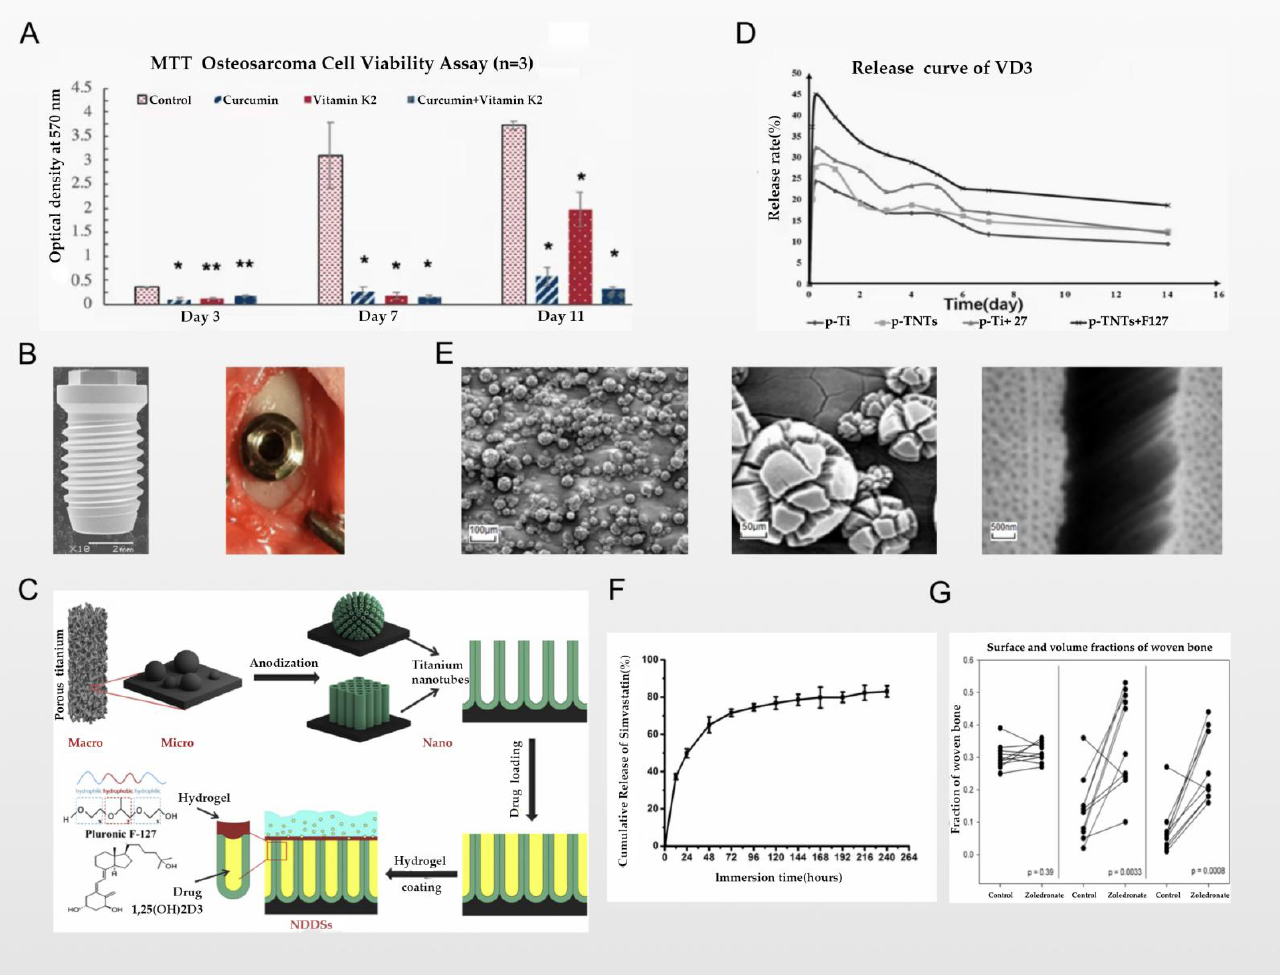
Figure 5. ( A ) MTT assay showing the effects of curcumin, vitamin K2, and curcumin + vitamin K2 on osteosarcoma cell viability (* denotes p ≤ 0.001, ** denotes p ≤ 0.05) ; reprinted with